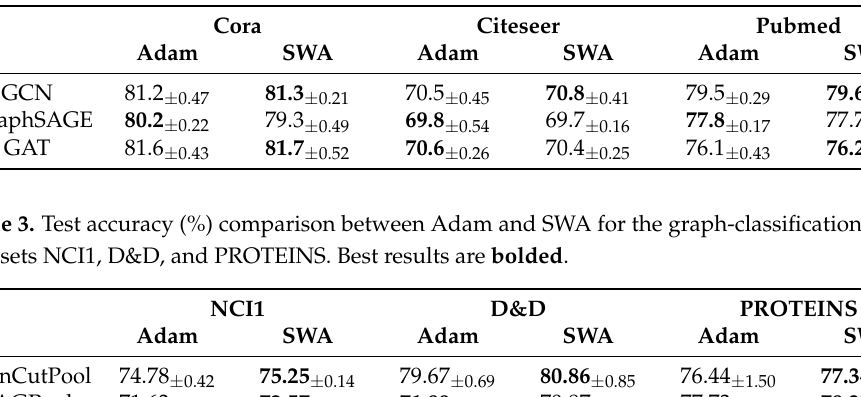
Table 2. Test accuracy (%) comparison between Adam and SWA for the graph-node-classification task on datasets Cora, Citeseer, and Pubmed. Best results are bolded . Cora Citeseer Pubmed Adam SWA Adam SWA Adam SWA